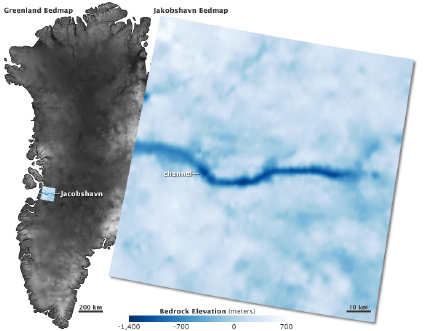
Fig. 5. Greenland and Jakobshavn Isbræ bed map elevations. Figure credit: NASA Earth